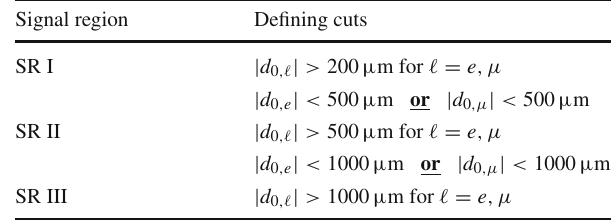
Table 1 Summary of the preselection criteria imposed on the signal Table 2 Definition of the signal regions conforming to table 1 of Ref. electrons and muons [36]. In addition to the criteria listed explicitly, all regions respect a | d 0 | upper cut of 10cm for both Electrons Muons